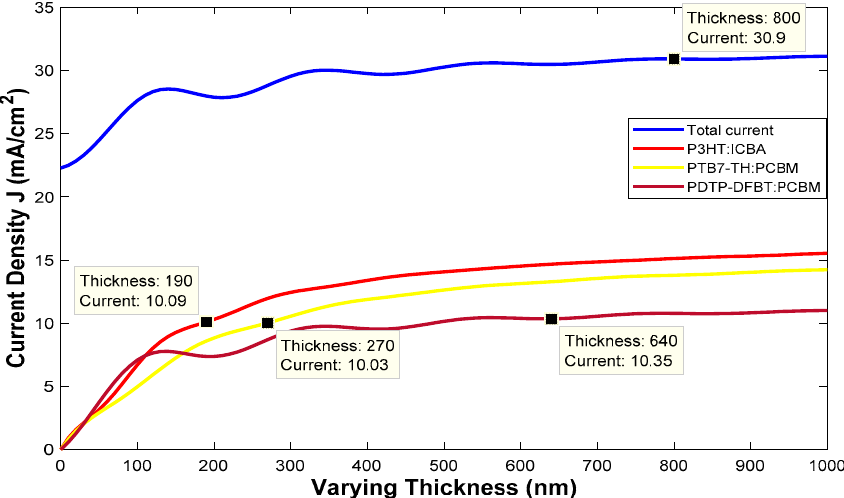
Figure 1. The thickness of the active layer is varied to obtain the optimal current for type 1 multi- junction polymer solar cells (PSC).